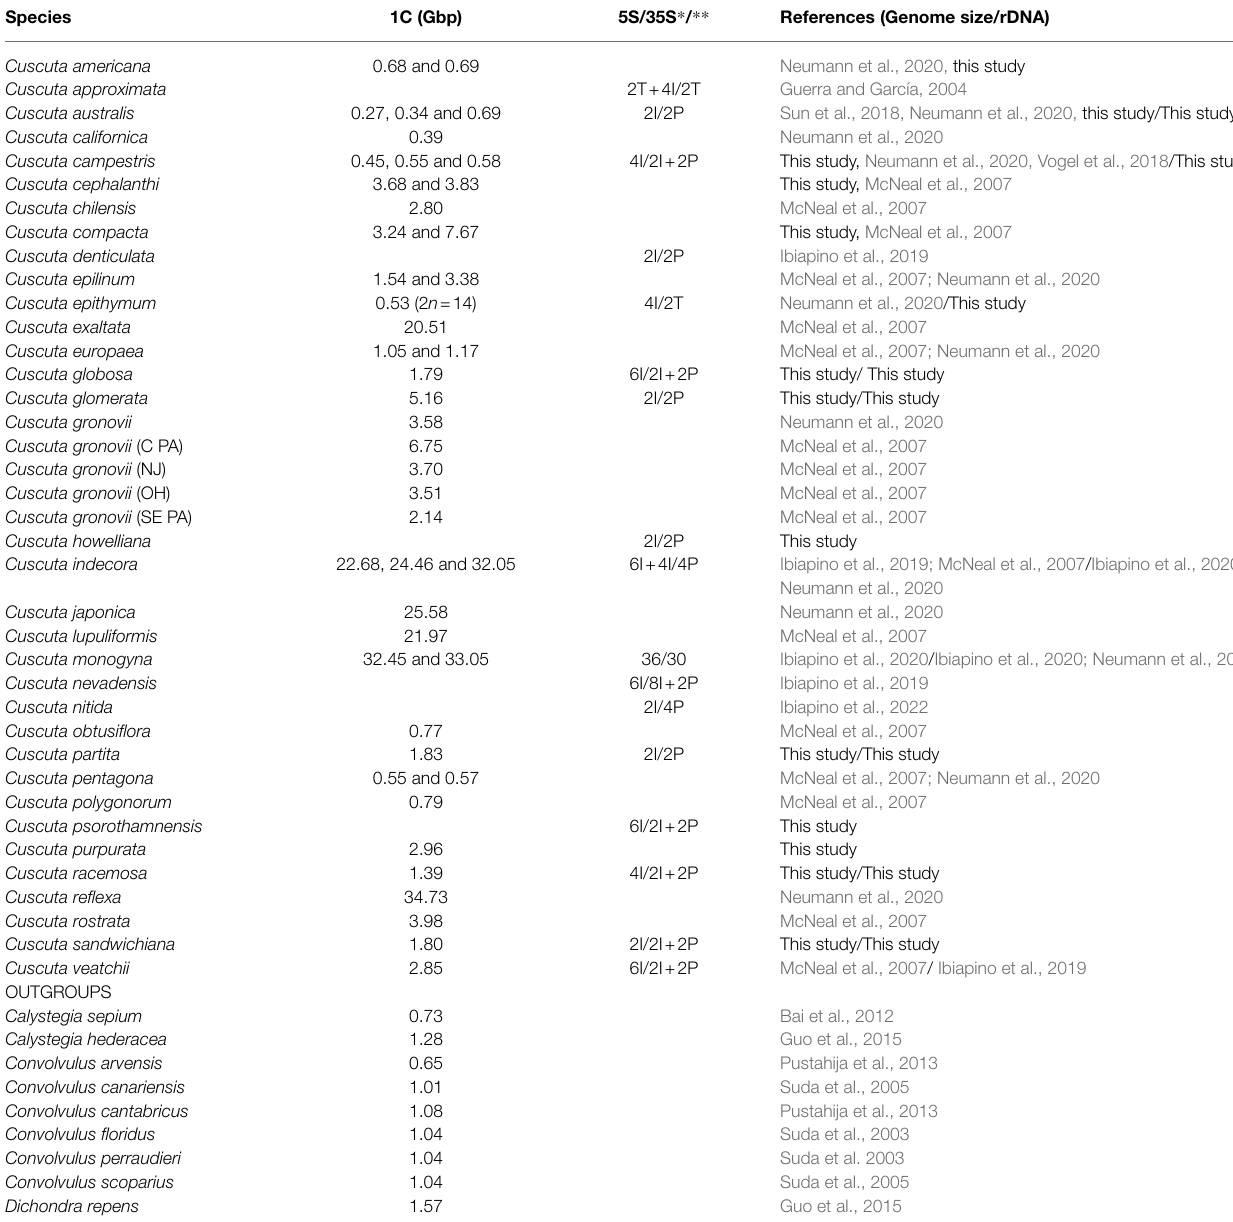
TABLE 1 | Data of genome size, 5S and 35S ribosomal DNA sites number, and position in species of the genus Cuscuta. Species 1C